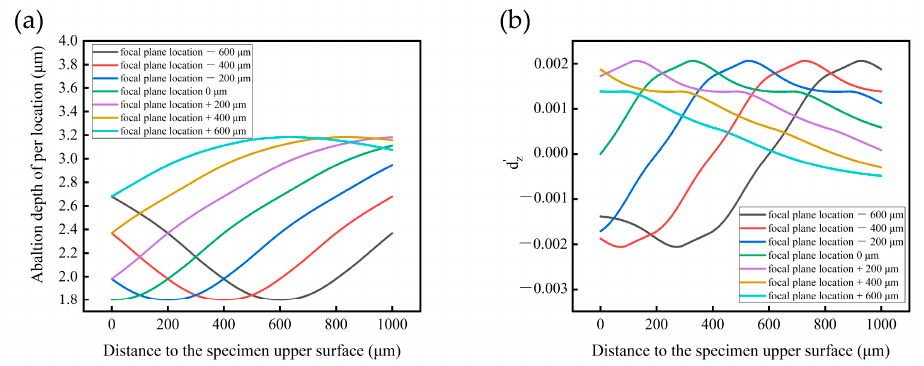
Figure 6. ( a ) Variation of ablation depth of a single point with distance from the specimen upper plane; ( b ) Variation of the derivative of the effective ablation depth with distance from the specimen upper plane.